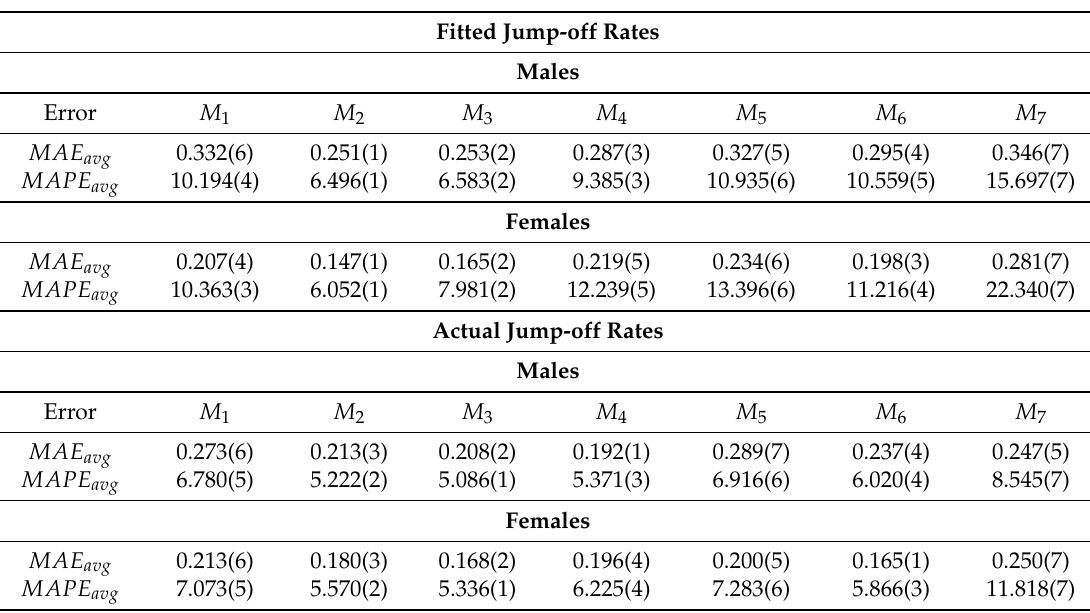
Table 6. Averaged values (ranking order in brackets) of the mean absolute error (MAE) and mean absolute percentage error (MAPE) measures of the forecasting period 2011–2013 using fitted or actual jump-off rates for males and females.